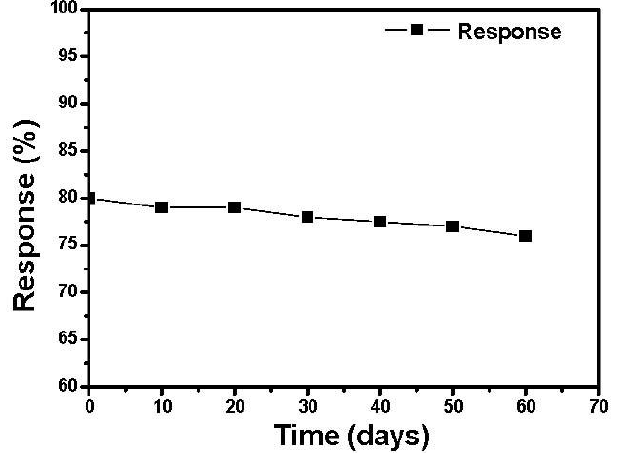
-PDDAC sensor as a function of time 2